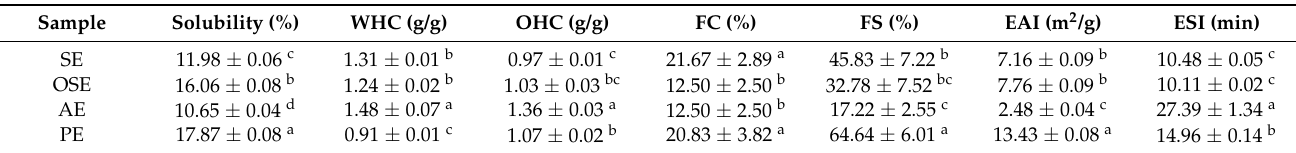
Table 4. Functional properties of field muskmelon seeds protein extracted by different oil extraction